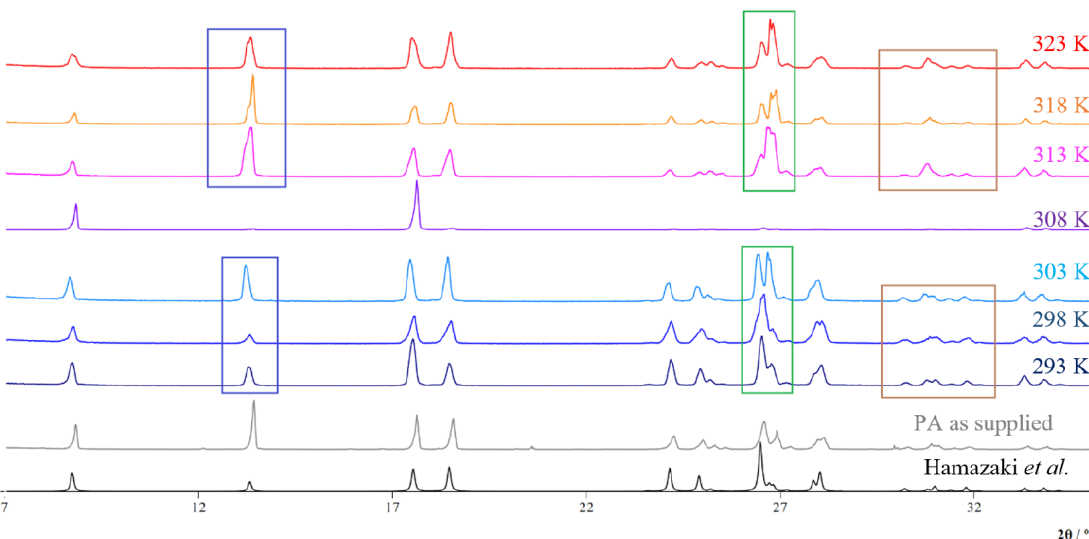
Figure 5. Comparison of X-ray diffraction patterns obtained at 293 ± 2 K for solid forms in equilibrium with the saturated PA aqueous solutions stabilized for one week at different temperatures. The PA as supplied (gray), and the pattern estimated from the SCXRD structure found in the literature [11] (black), are also plotted. All the diffractograms were normalized to the peak of highest intensity ( I n ) and plotted using EasyGraphII [19].